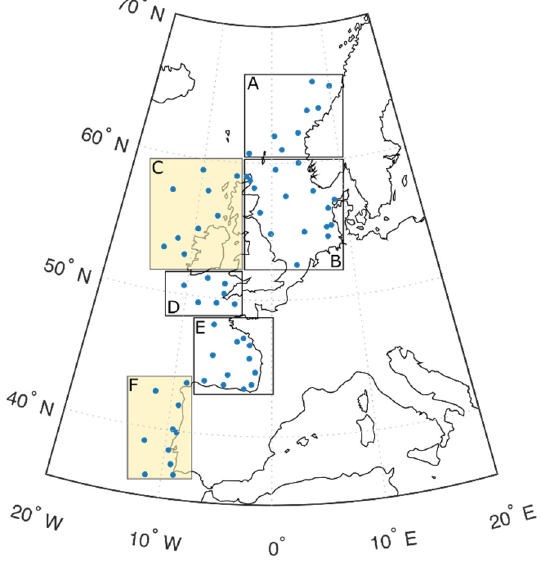
Figure 3. Map showing the zones of ocean for which corresponding wave climates were consid-